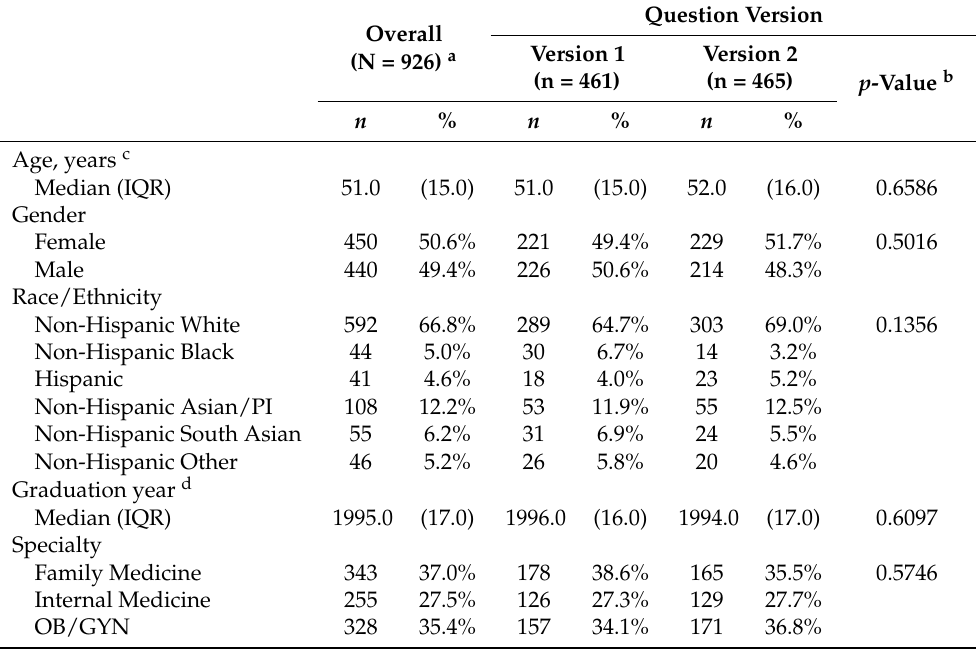
Table 1. Sample Characteristics by Question Version, (N =